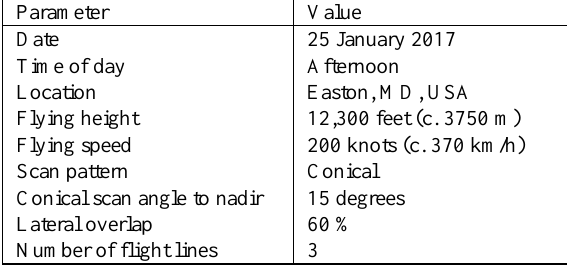
Table 1. Data acquisition parameters for Easton dataset (courtesy Hexagon Geosystems).